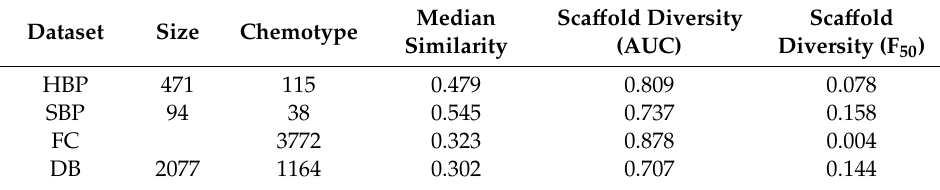
Table 4. Summary of structural diversity of HBP, SBP, and reference